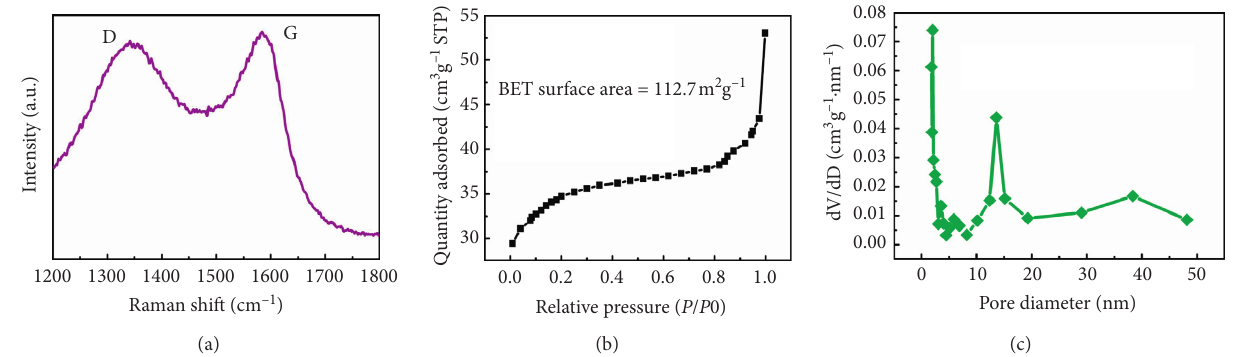
Figure 6: (a) Raman spectrum and (b, c) nitrogen adsorption-desorption isotherm of the prepared Ni